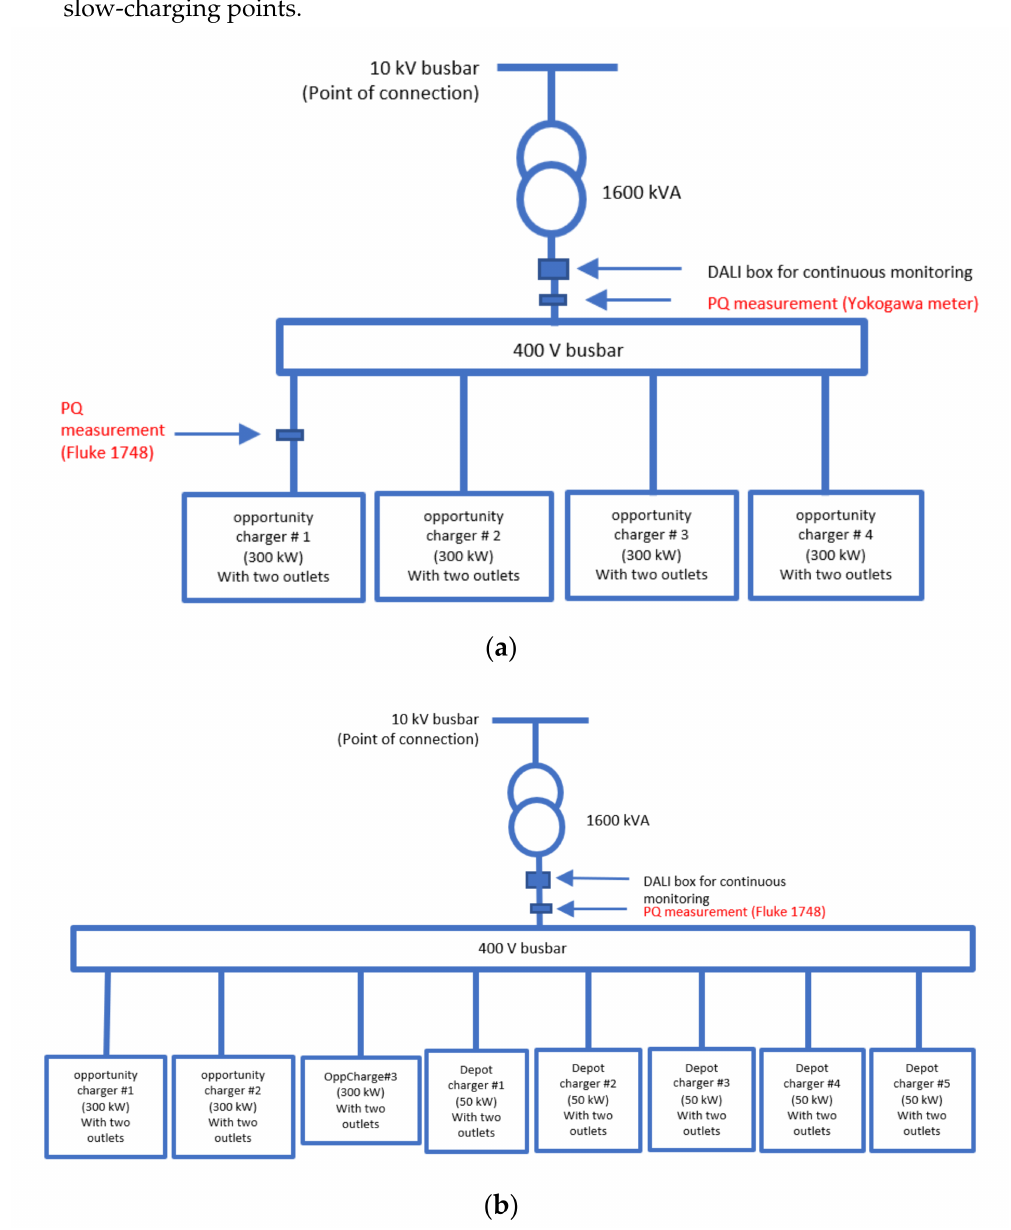
Figure 5. Configuration of transformers at the installation along with PQ measurement devices. ( a ) Transformer # 1; and ( b ) Transformer #